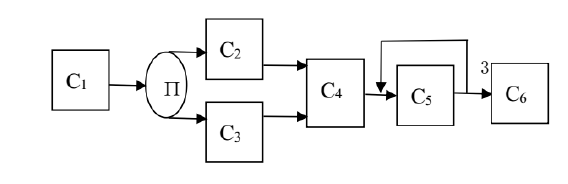
Figure 6. The logical structure of the component system.